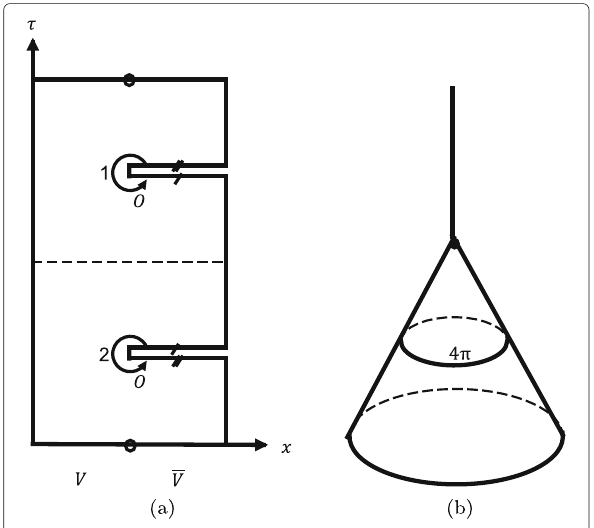
(cid:3) (cid:2) ρ 2 can be computed by the 2-sheeted Riemann surface Fig. 1 tr V shown in a . The period of τ in region V is twice of that in region ¯ V (see the text). A close loop around point O goes through contours 1 and 2 with a total angle 4 π . For a system of infinite spacetime volume, a can be drawn as b with a 2-dimensional cone of angle 4 π and 2 co-dimensions. The line connecting to the tip of the cone in b denotes the 2-dimensional brane which is the interface. The replica (cid:3) (cid:2) ρ n with n → trick requires generalizing this picture to tr V